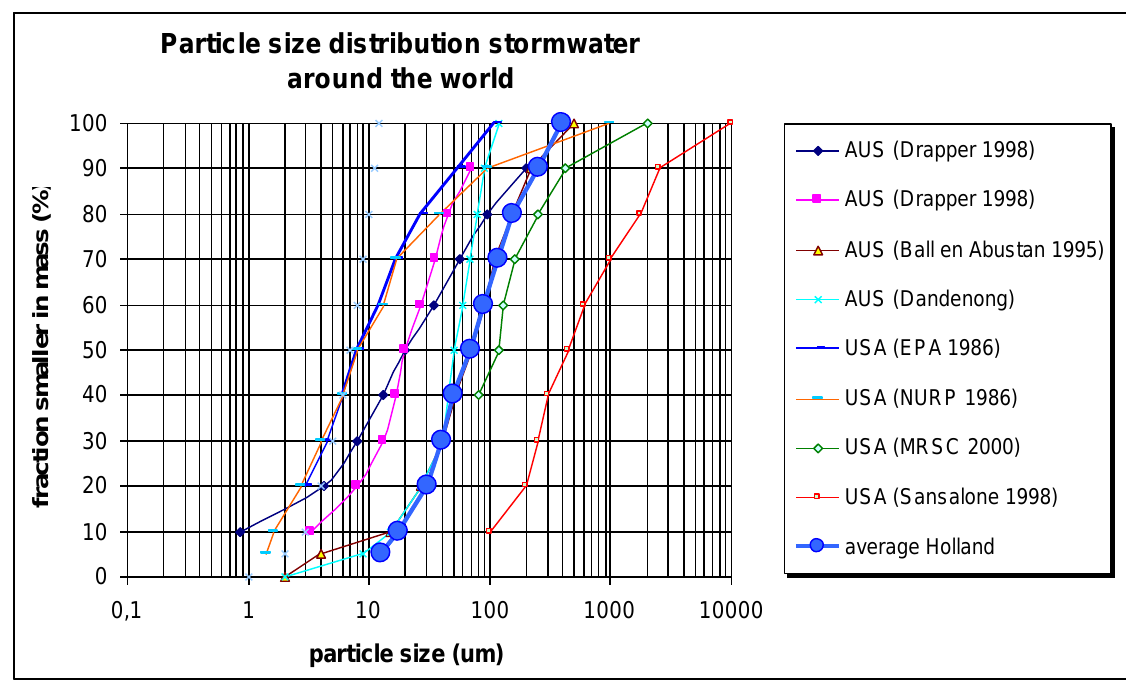
Figure 4. Particle size distributions in several stormwater sewer systems around the